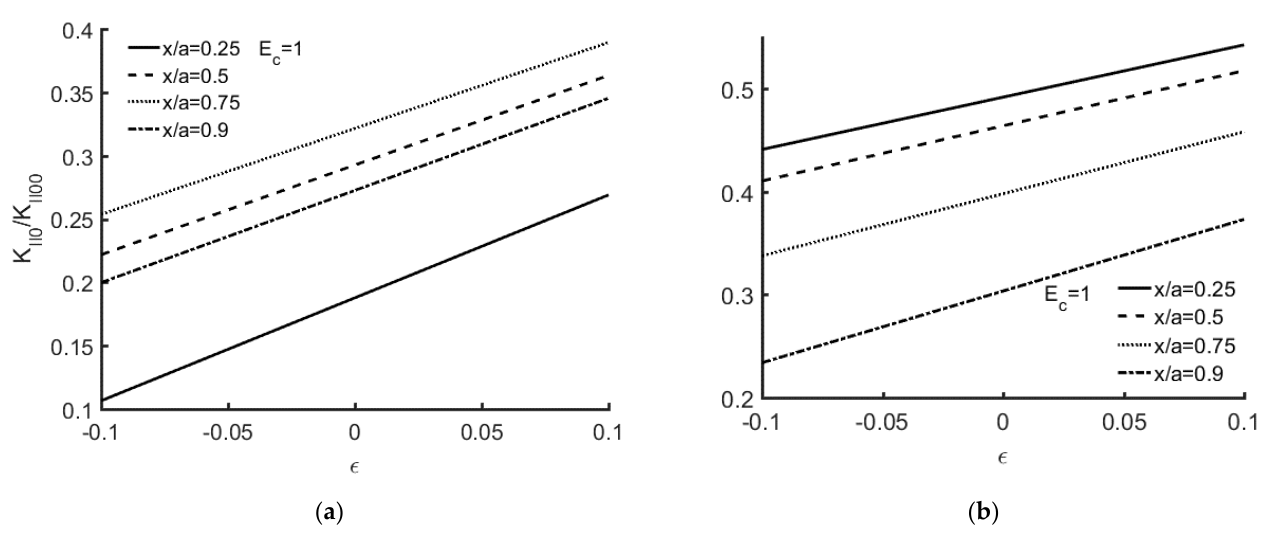
Figure 3. ( a ) Q c 0 / Q 00 versus ε with x/a = 0.25, 0.5, 0.75, 0.9 for Ec = 1. The orthotropic material listed in Table 1; ( b ) Q c 0 / Q 00 versus with x/a =0, 0.25, 0.5, 0.75 for Ec = 1. The isotropic material listed in Table 2. Figure 4a,b display K II0 /K II00 versus Ec, where K II0 represents K I00 when Q c0 = 0 and =0. It is easily seen that K II0 /K II00 decreases with an increase of Ec for